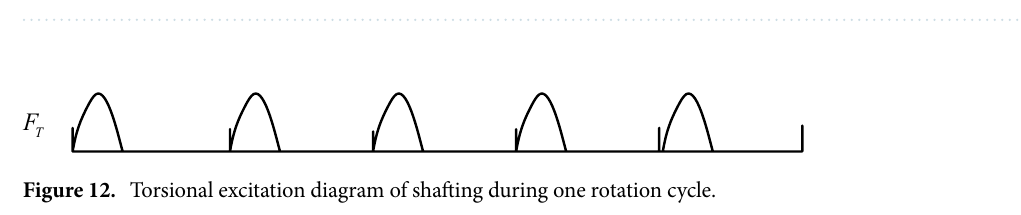
Figure 11. Excitation diagram of each moving blade during one rotation cycle.